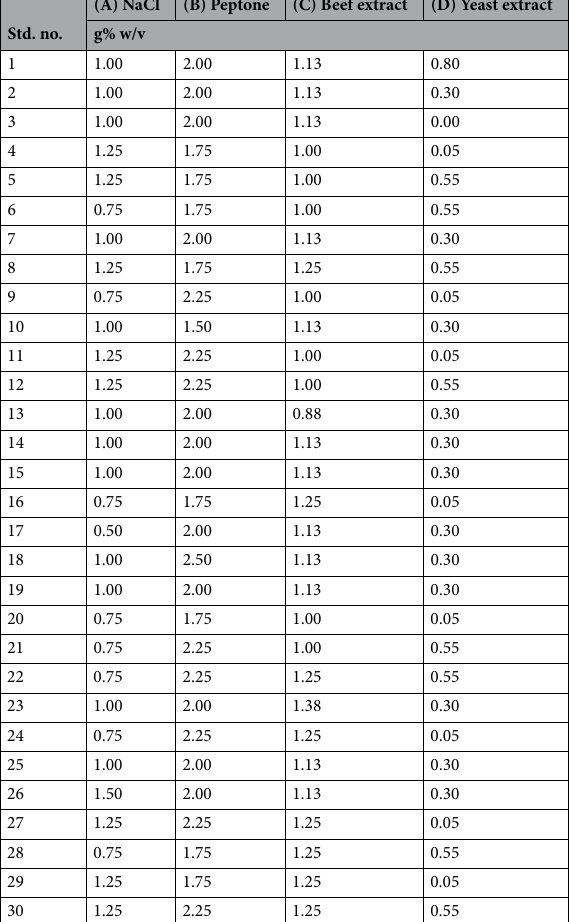
Table 2. Central composite